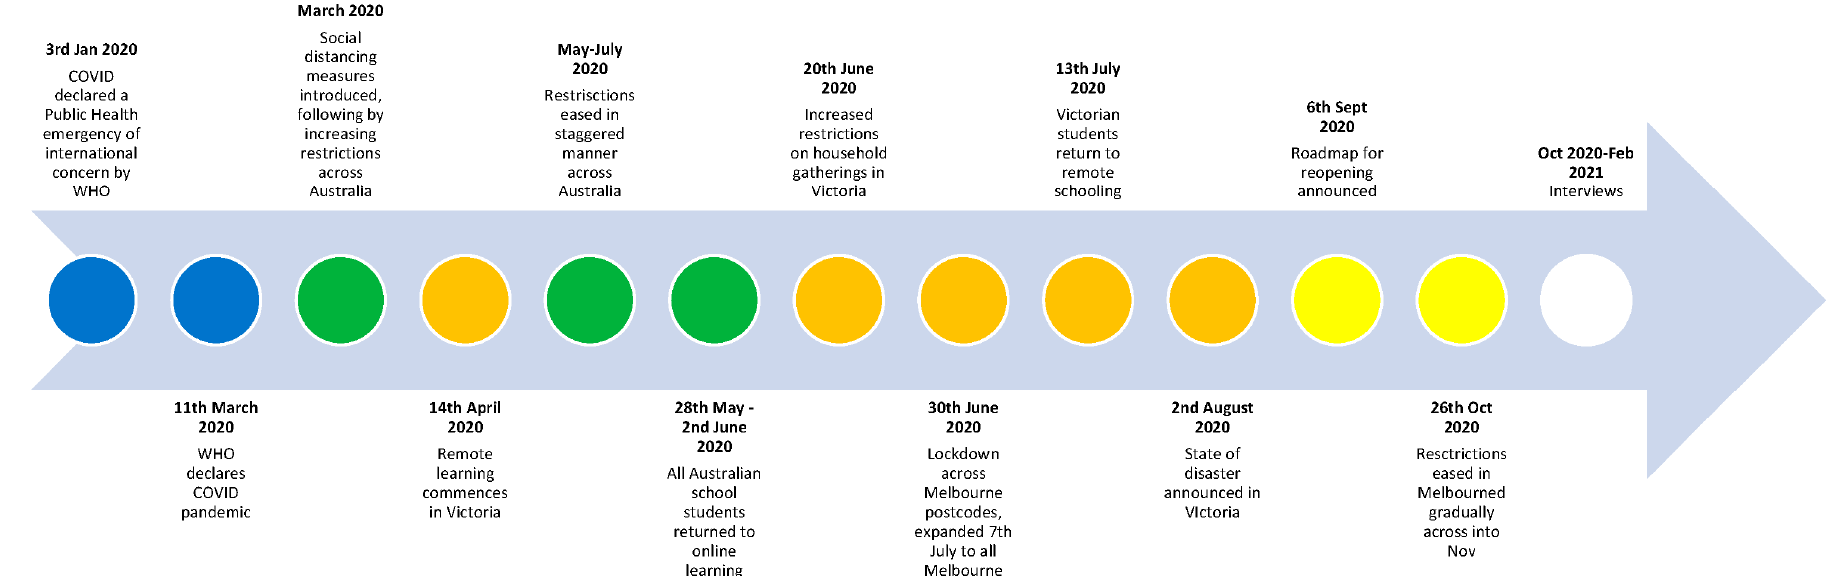
Figure 1. Key milestones in Australia’s response to COVID-19, indicated by green circles, and Victorian-specific restrictions, where orange indicates increased restrictions, and yellow indicates reduced restrictions.